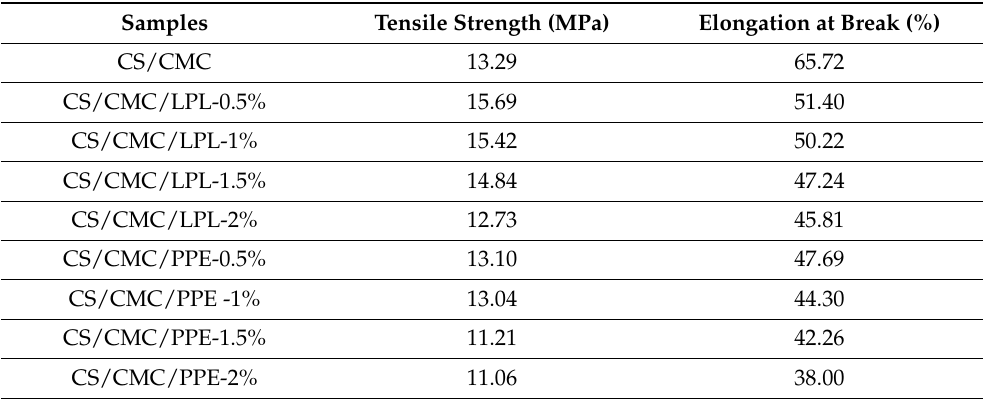
Table 10. Tensile strength and elongation at break of CS/CMC composite films with various probiotics loading